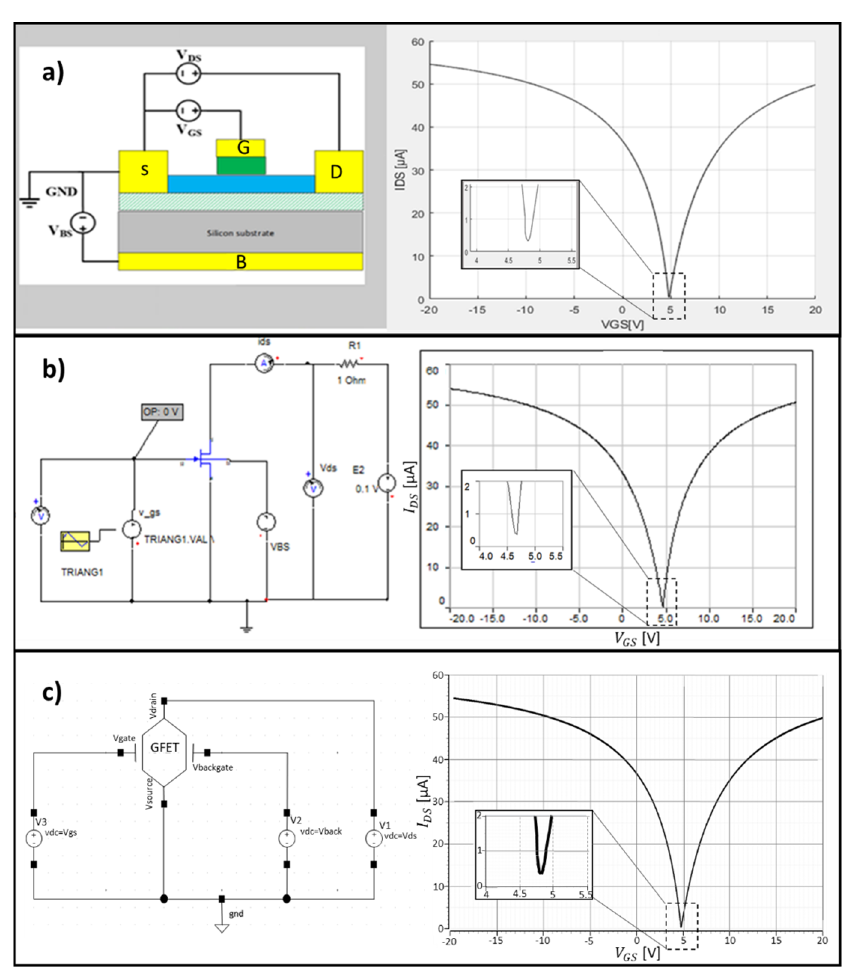
Figure 7. Interface of the GFET platforms: ( a ) MATLAB; ( b ) Simplorer; and ( c ) Cadence. The results presented for the GFET transfer characteristic were obtained from [64].